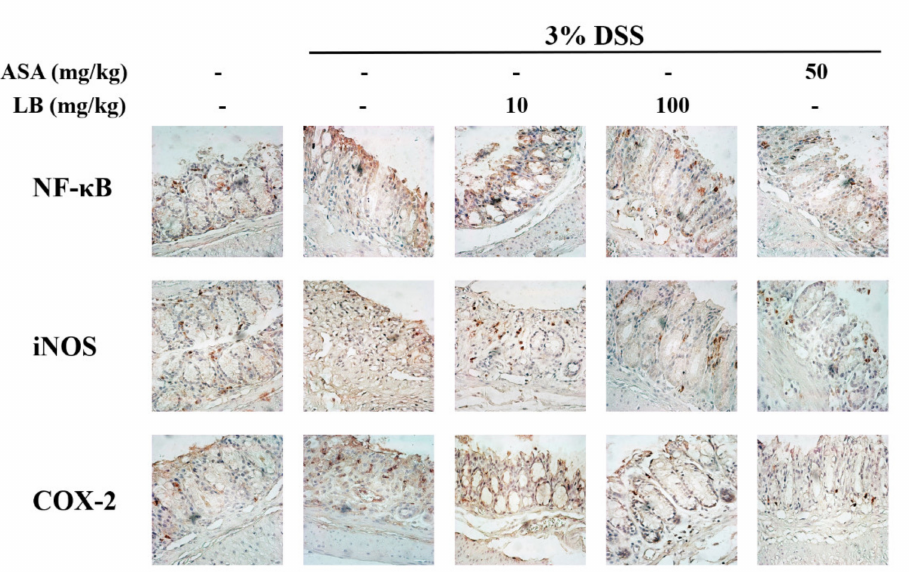
Figure 4. LB attenuated the expression of NF- κ B, COX-2, and iNOS in colon tissue in DSS-induced UC mice: expression of NF- κ B, iNOS, and COX-2 in colon tissue (scale bar = 100 µ m, 400 ×